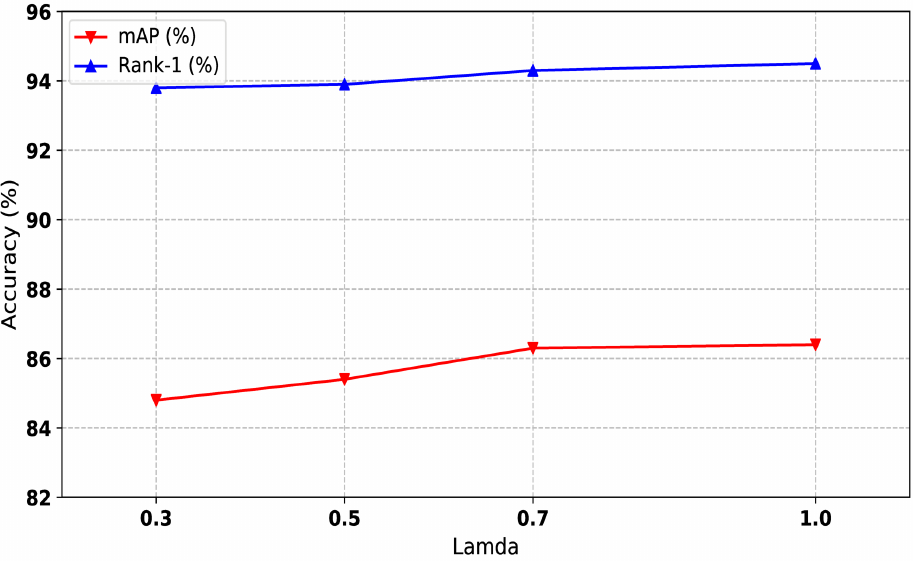
Figure 6. The impact of the feature learning coefficient of labeled data of our method on Market1501 dataset. Both mAP and Rank-1 are used to evaluate the performance. The x-axis represents the joint training